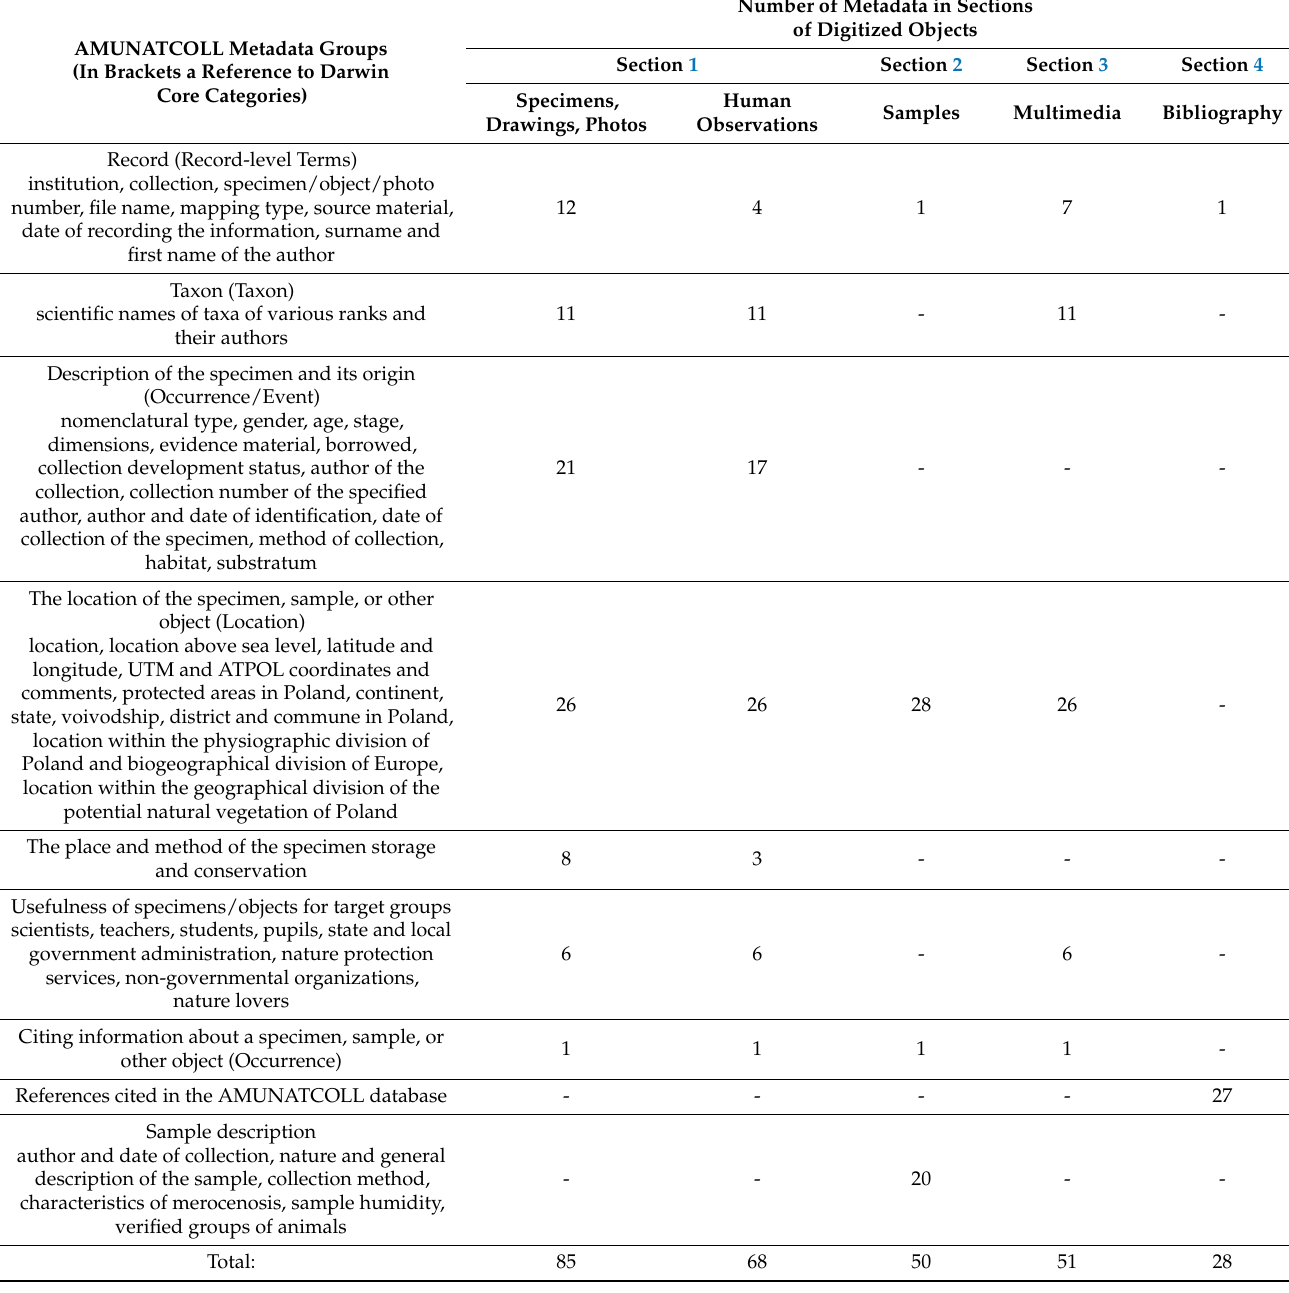
Table 1. AMUNATCOLL metadata